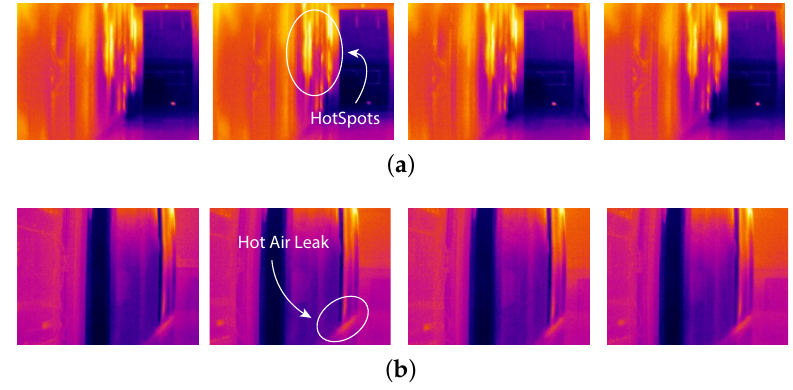
Figure 13. Thermographic analysis of two thermographic nodes at different times. Images have been captured in the second data collection at times 1 h, 10 h, 20 h and 27 h. ( a ) Thermographic Node 3; ( b ) Thermographic Node